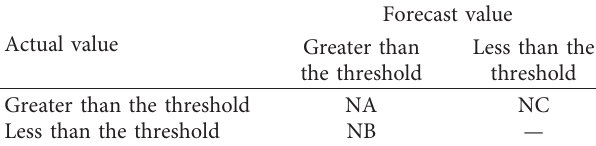
Table 2: Verifying